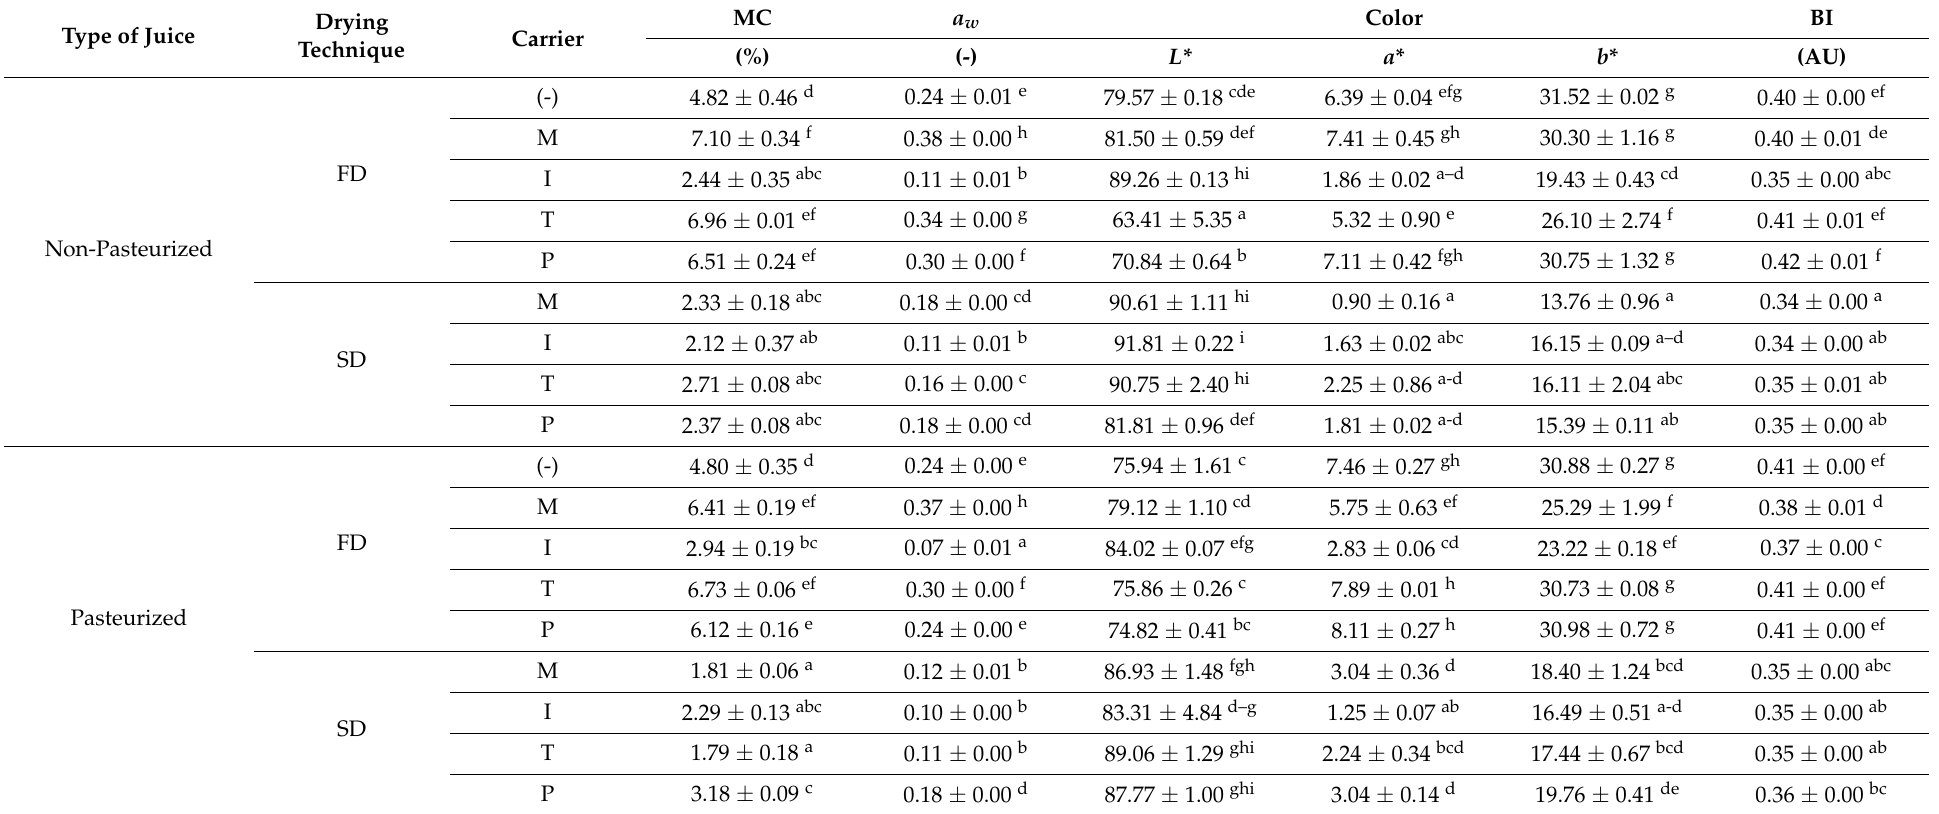
Table 2. Moisture content (MC), water activity ( a w ), color (CIE L * a * b *) and browning index (BI) of rosehip juice powders obtained after freeze- and spray drying ( n = 2; average ± standard deviation). (-)—no carrier addition, M–maltodextrin, I–inulin, T–trehalose, P–palatinose, FD—freeze-drying, SD—spray drying, AU—arbitrary units; a,b,c,d,e,f,g —the same letters within a column indicated no statistically significant differences (HSD Tukey test; p ≤